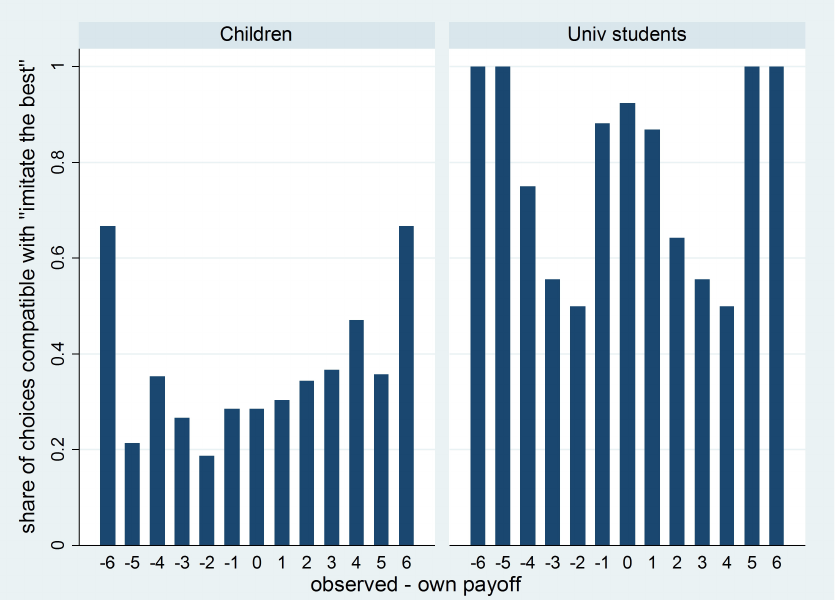
Figure 4. Share of choices that are compatible with “imitate the best” depending on payoff difference (=observed payoff − own payoff from previous